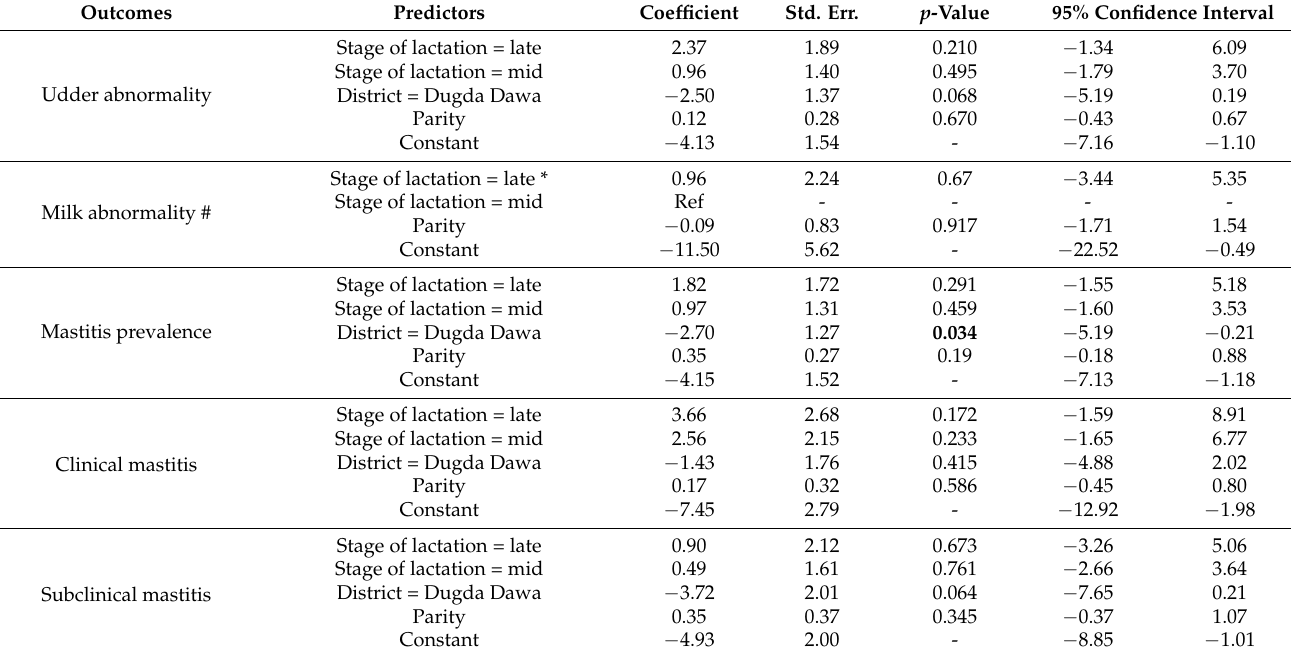
Table 5. Effects of stage of lactation, district, and parity on the prevalence of udder and milk abnormalities, and clinical and subclinical mastitis in